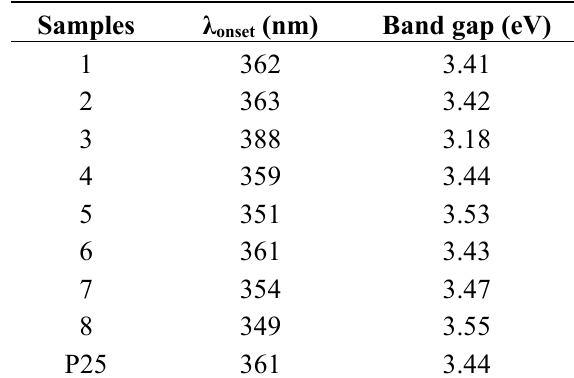
Table 4. λ onset and band gap from UV-Vis (UltraViolet-Visible) spectra of samples 1–8 and